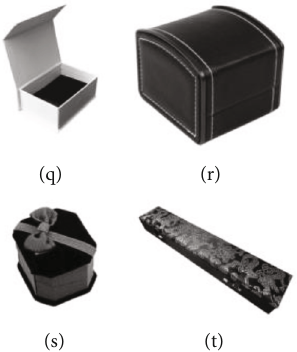
Figure 2: 20 representative jewelry packaging Table 2: Evaluation gradient of consumer L